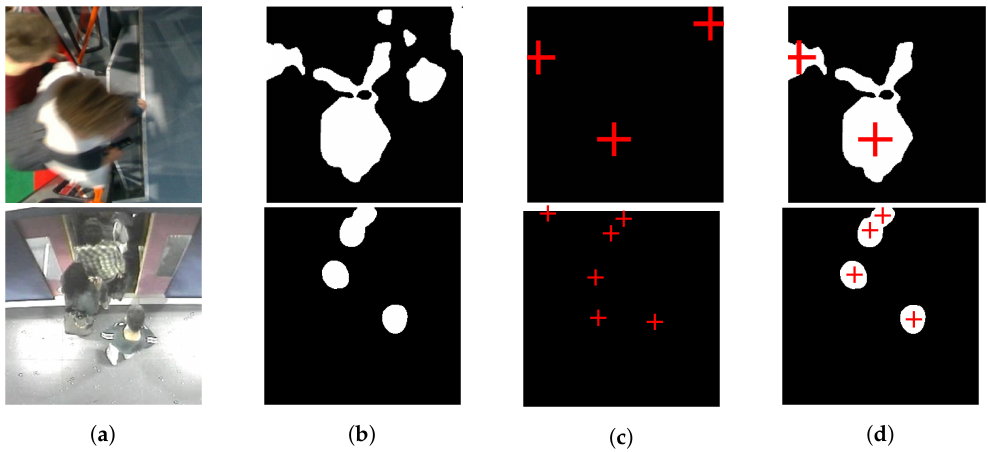
Figure 1. False detection that can be corrected by proposed system. ( a ) is raw image, ( b , c ) represent output of system 1 and 2. ( d ) is output of proposed